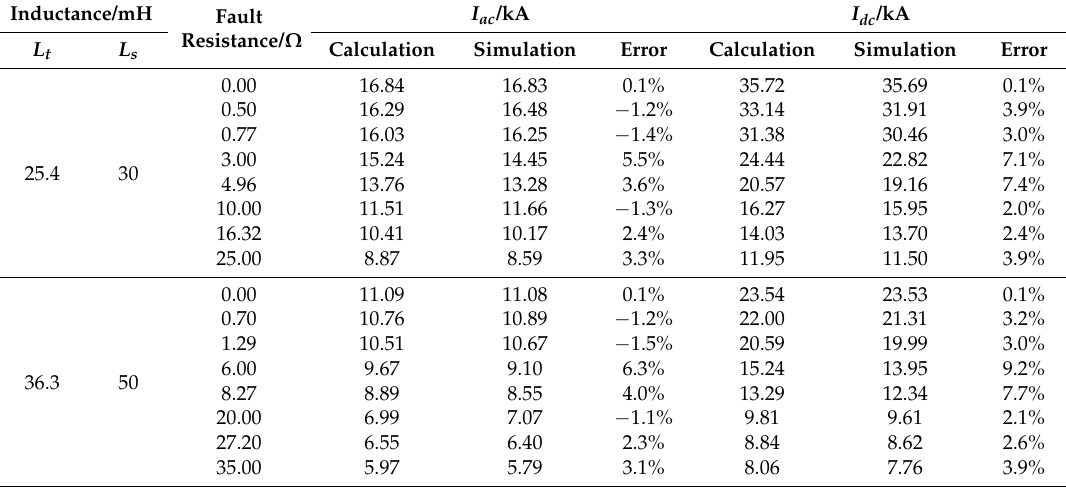
Table 2. Comparison between the calculation results and simulation results of fault